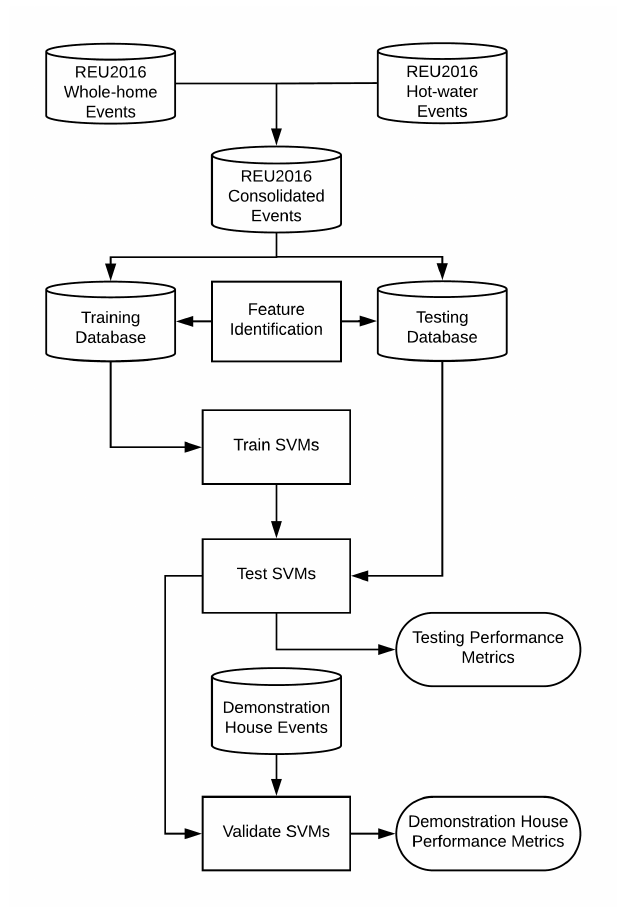
Figure 1. After datasets are curated and assembled, support vector machines (SVM) are used to train classifiers and test their performance. Following testing, SVMs are validated on data from a demonstration home that were collected under different conditions relative to the training